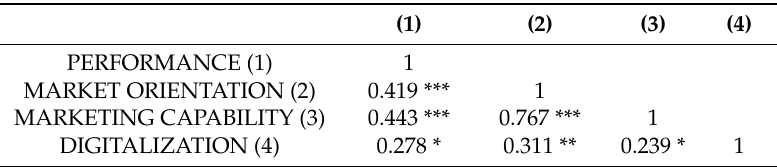
Table 1. Correlation results for the studied